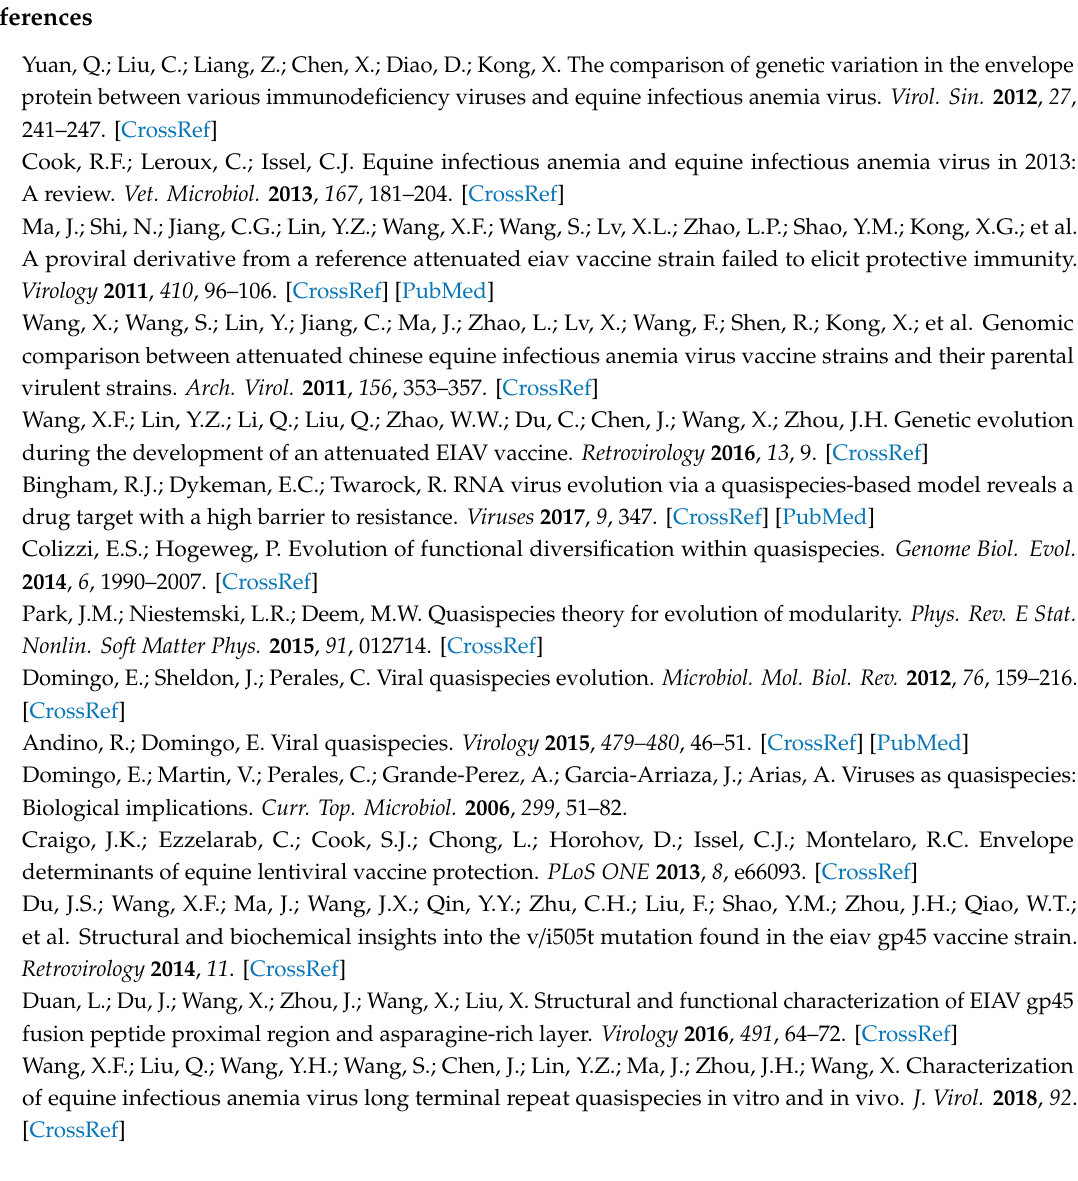
Figure S1: The morbidity of varied EIAV strains. Figure S2: WebLogo presentation of variability in EIAV env . Figure S3: Quantification of the env - ∆ 236D-phenotype and env -236D-phenotype sequences located in the V4 region of env by double-probe real-time